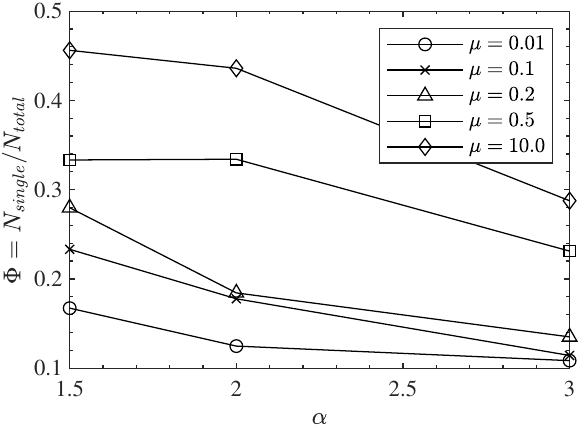
Figure 6. The fraction of single particles, Φ , vs. the aspect ratio α for various values of µ .